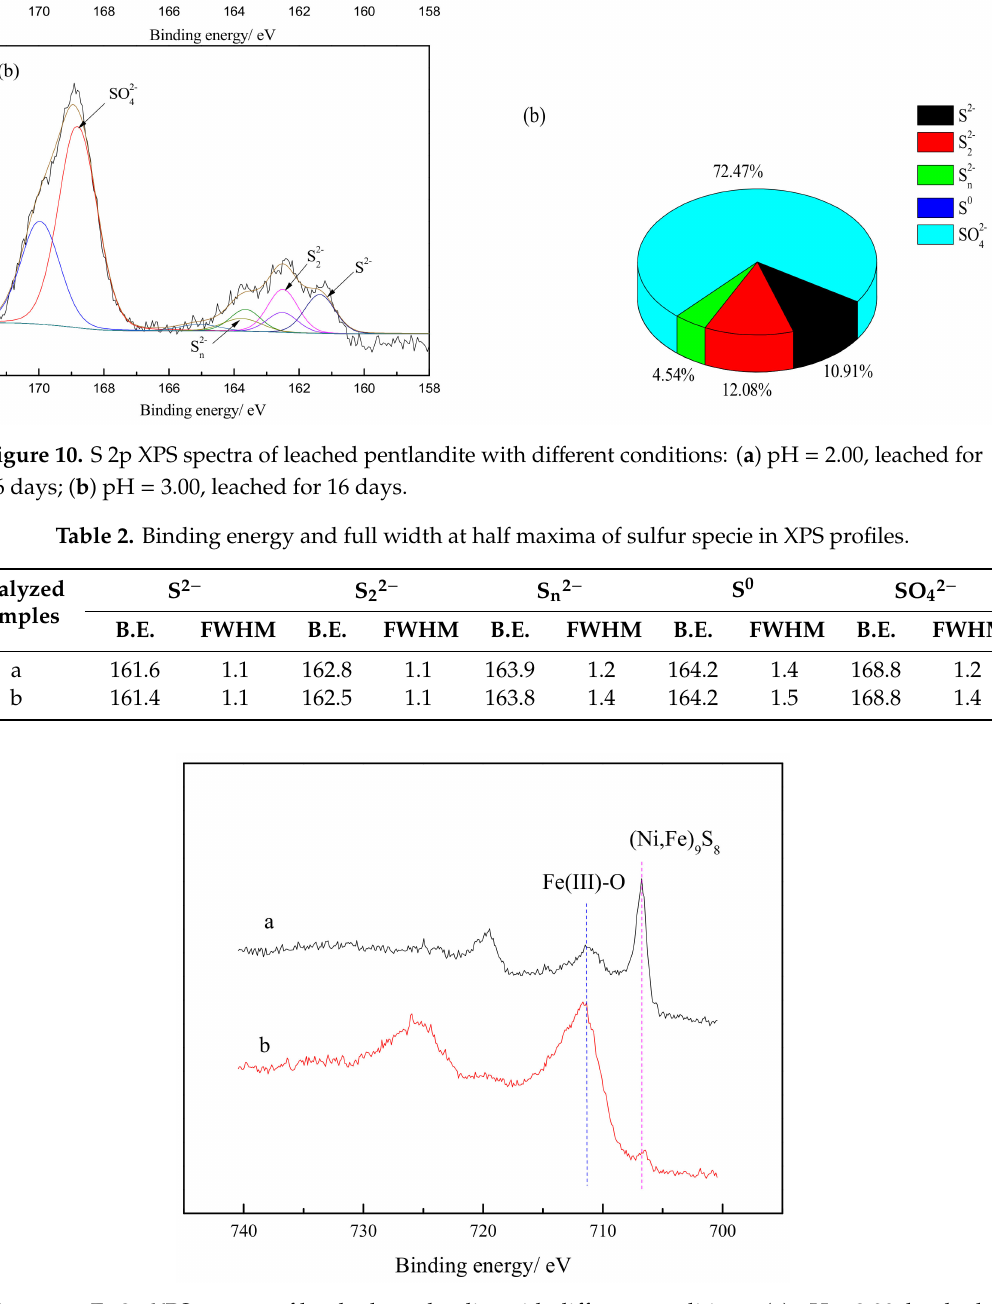
Figure 11. Fe 2p XPS spectra of leached pentlandite with di ff erent conditions: ( a ) pH = 2.00, leached for 16 days; ( b ) pH = 3.00, leached for 16